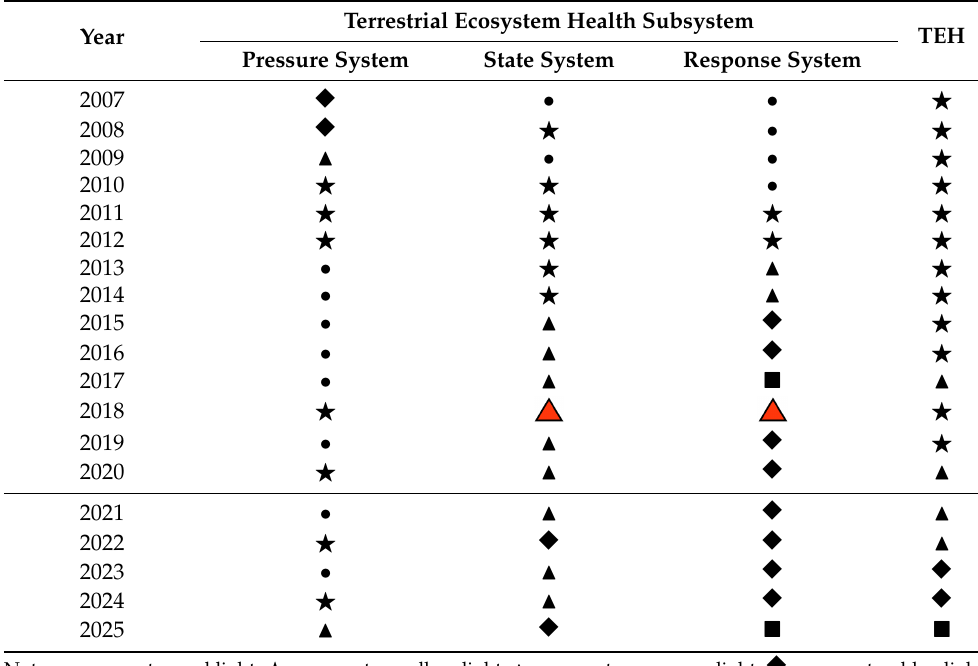
Table 3. Early-warning indicator lamps for the health status of the terrestrial ecosystem.